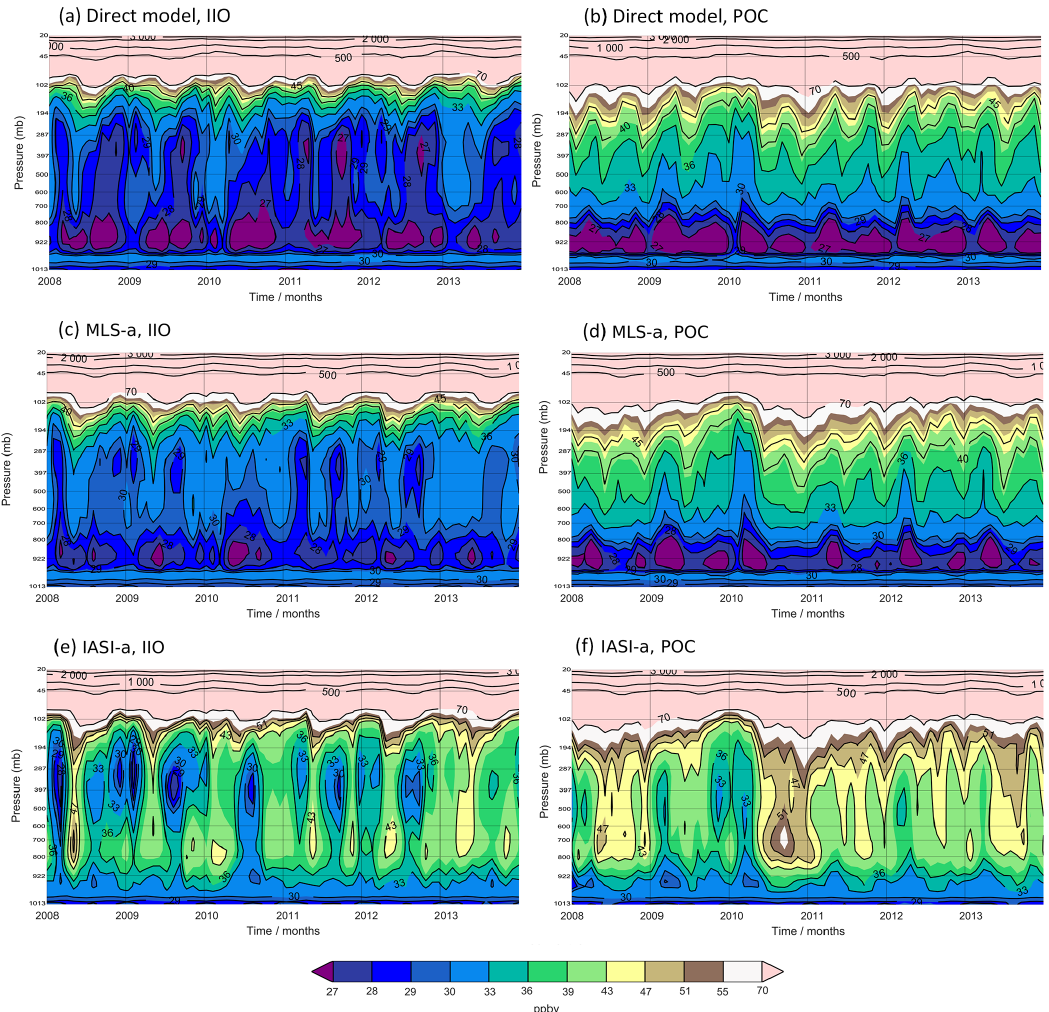
Figure 8. Monthly mean time series of ozone vertical profiles (units ppbv) versus pressure for the IIO region (a, c, e) and the POC region (b, d, f) . The abscissa goes from January 2008 to December 2013. Panels (a, b) correspond to the Direct Model, (c, d) to the MLS-a and (e, f) to the IASI-a simulations. Pressure scale goes from 1013 to